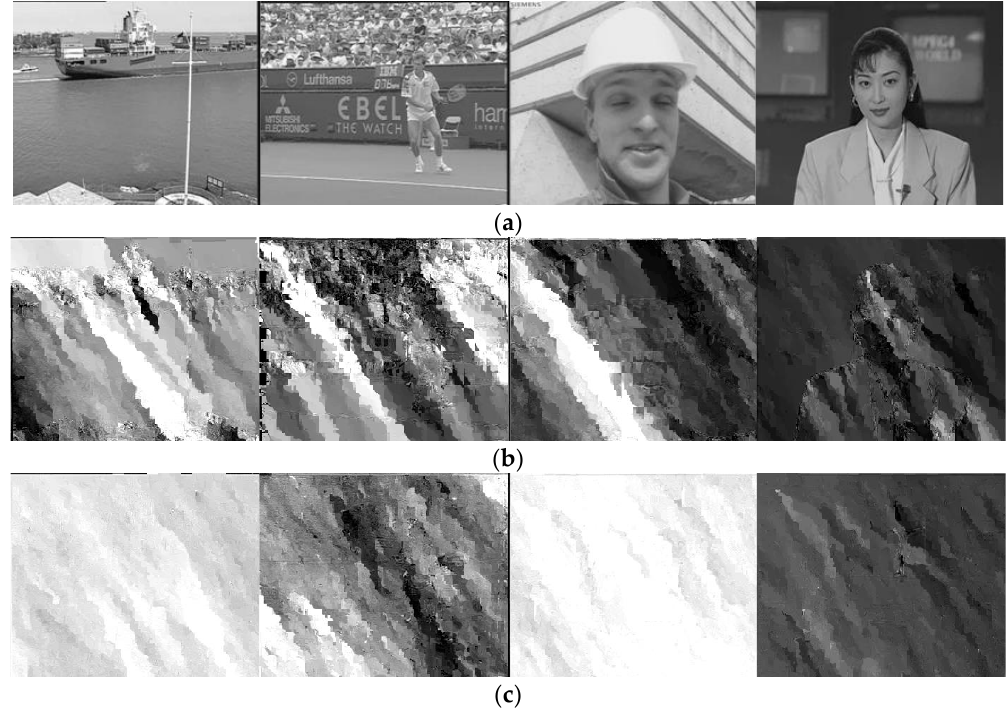
Figure 8. Encryption effect comparison. ( a ) Original frame, ( b ) I-Q-M encryption, ( c ) proposed encryption.